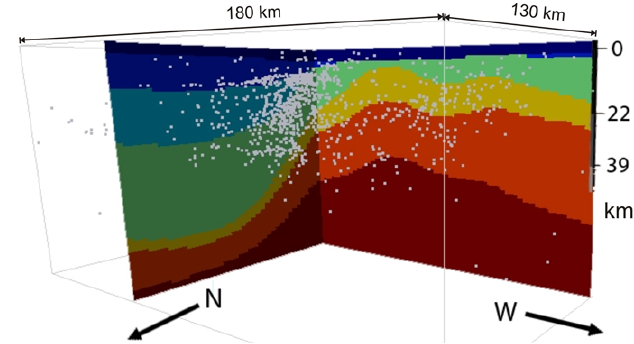
Figure 2. A smoothed 3D model for the Friuli area composed of five ho- mogeneous layers with curved interfaces. White dots, hypocenters esti- mated using the Hypo3D